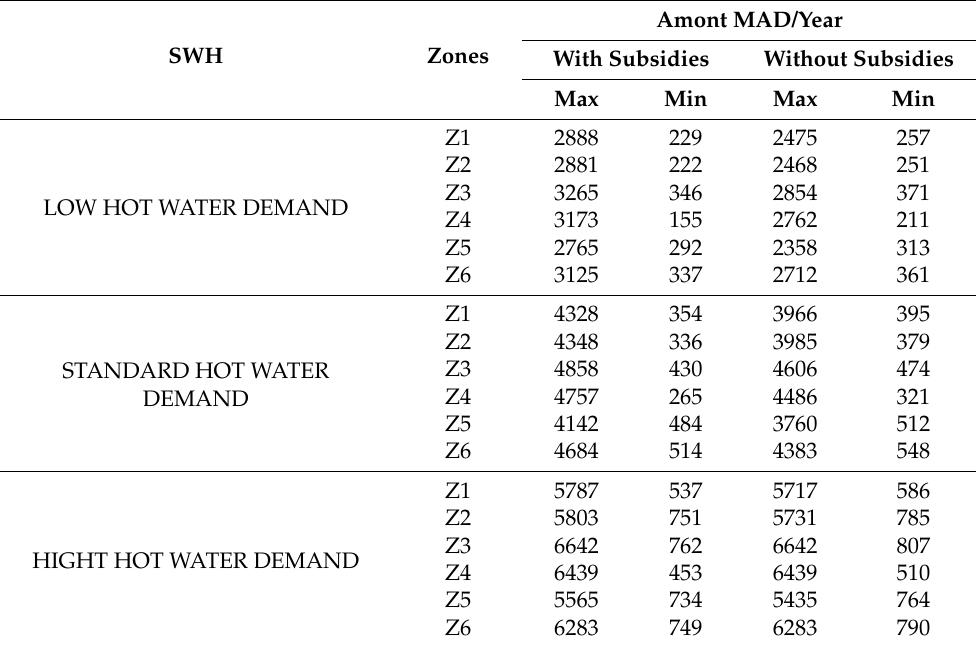
Table 15. Amount saved by installing a solar water heater for an individual building. SWH Zones